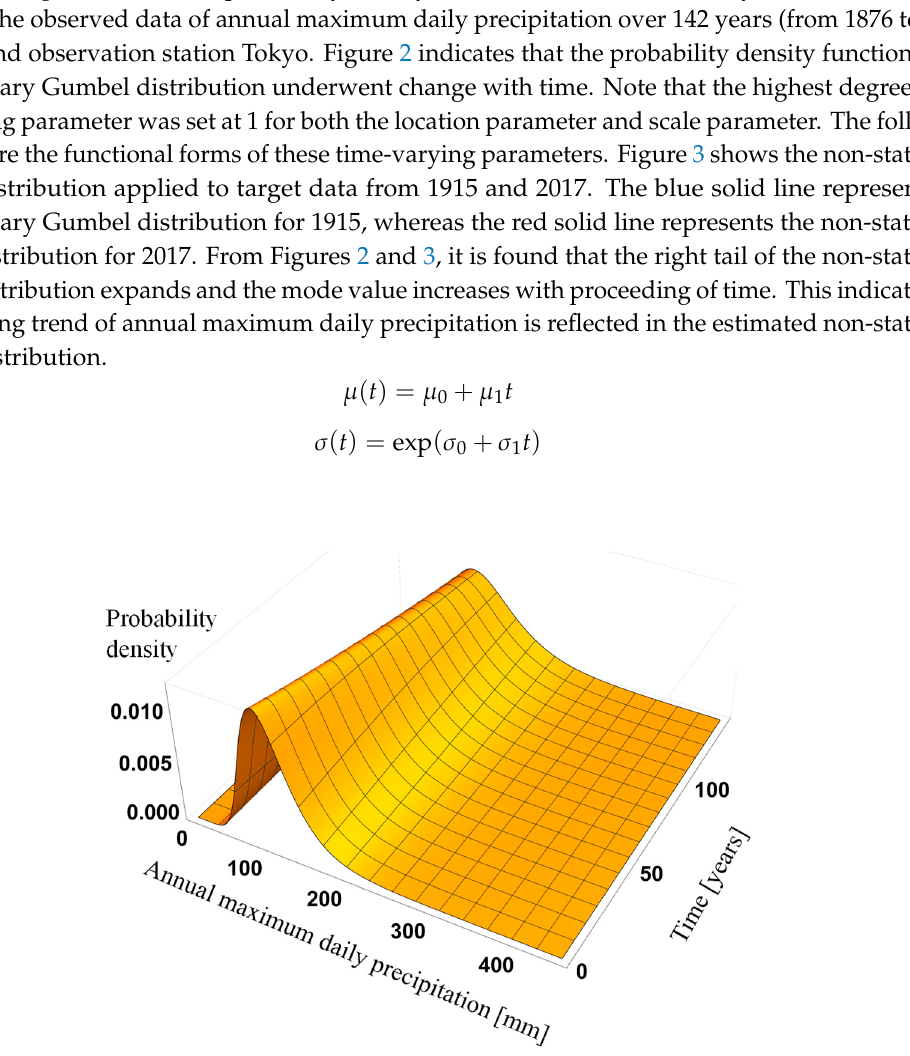
Figure 2. Probability density function of the non-stationary Gumbel distribution applied to the observed data of the annual maximum daily precipitation over 142 years (from 1876 to 2017) at the Meteorological Agency ground observation station Tokyo. The axis of the depth direction represents the number of elapsed years.